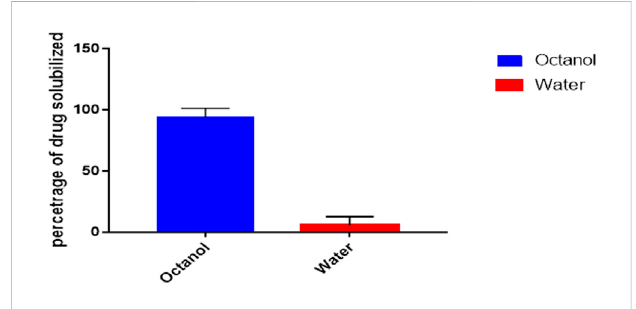
FIGURE 2 Partition co-ef fi cient of ER using